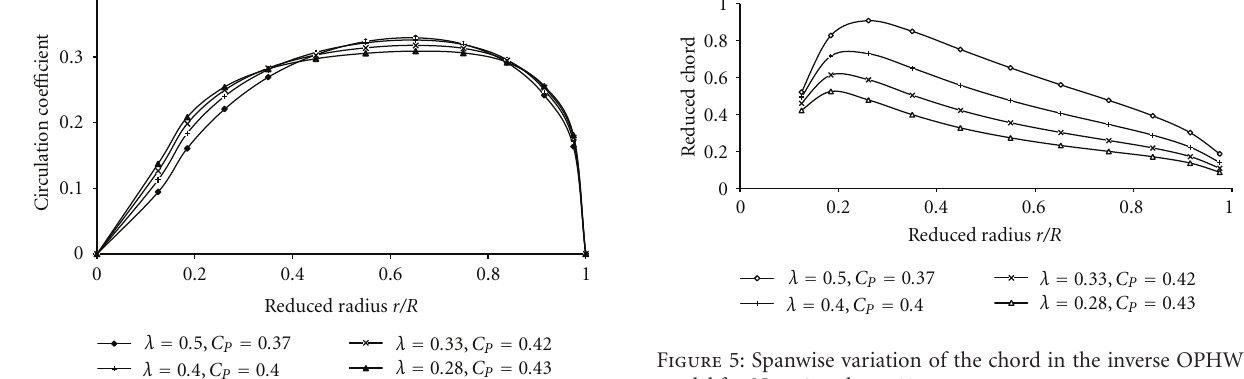
Figure 5: Spanwise variation of the chord in the inverse OPHWT model for N b = 3 and α = 8 ◦